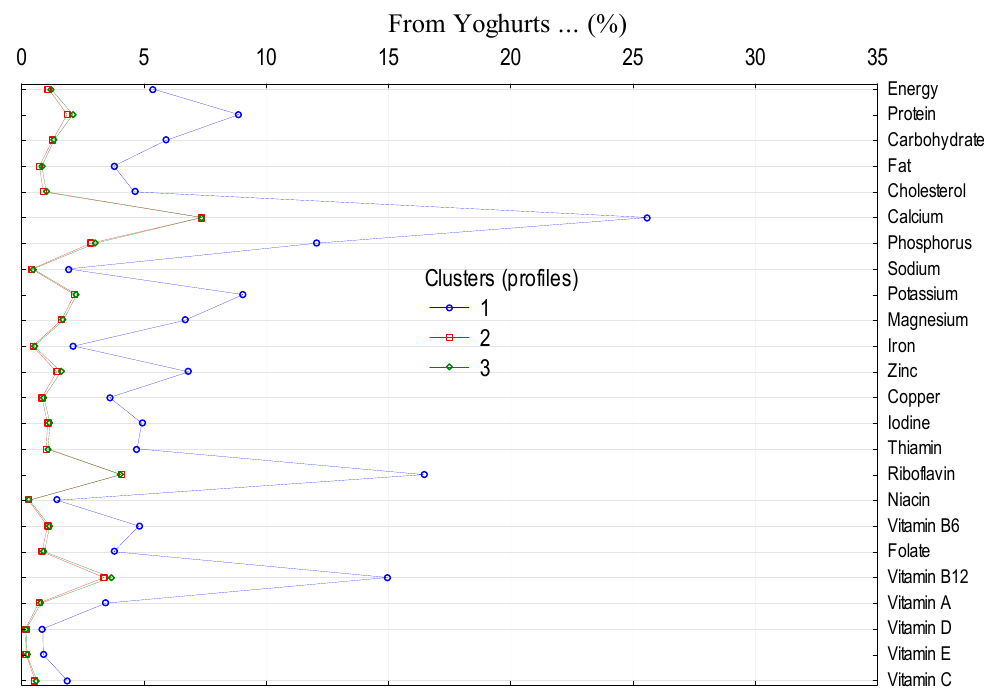
Figure 3. Cluster analysis: supply of energy and nutrients from yoghurts, milk drinks and other dairy products to the average Polish diet. 242